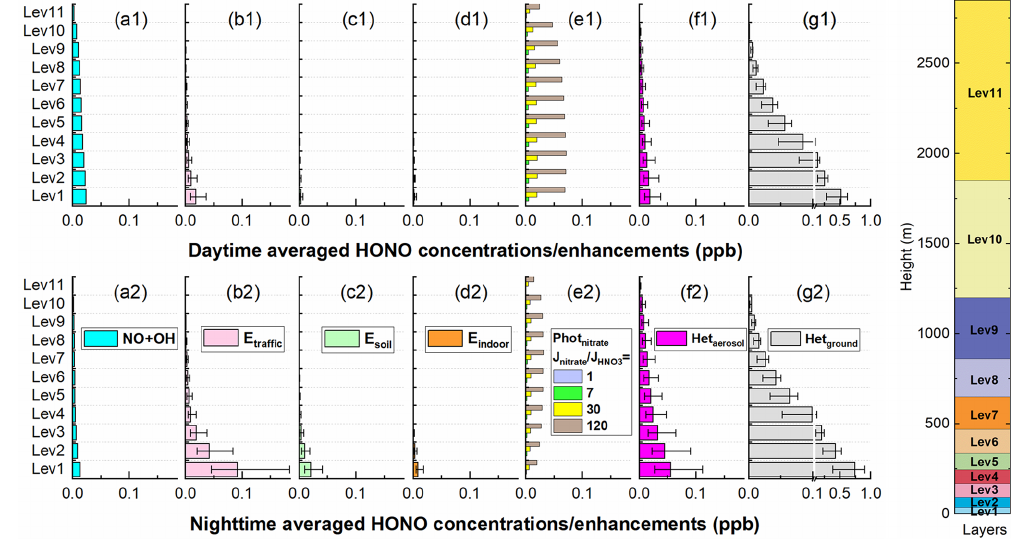
Figure 6. The 95-site-averaged daytime/nighttime HONO concentrations/enhancements at different heights for the NO + OH reaction ( a1 and a2 ) and each of the six potential HONO sources ( b1–g1 and b2–g2 ) during 11–31 October 2018. The error bar denotes the uncertainties of each potential HONO source in HONO concentrations (Table 2). The right panel denotes the approximate height of each vertical layer above the